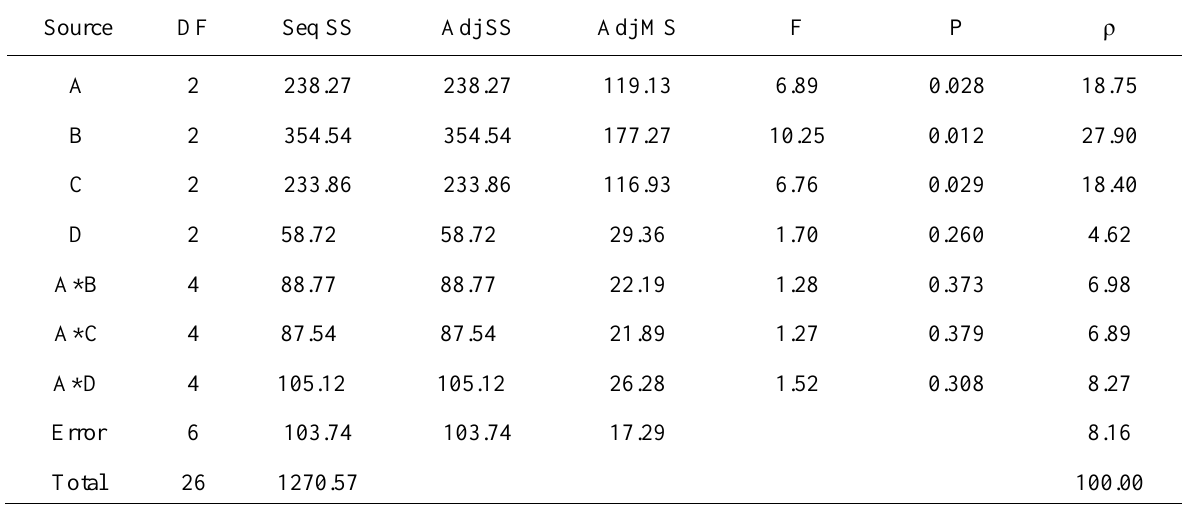
Table 4. ANOVA for the response of Cr +6 removal efficiency (%) in Taguchi method.